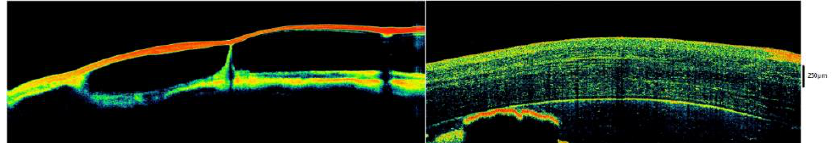
Figure 7. Degeneration of the ocular surface epithelia by portable optical coherence tomography (OCT). Using a portable spectral-domain (SD) OCT in research setting, a progressive degeneration of the ocular surface epithelia and underlying layers can be monitored over time in absence of a physiological tear production. The structural disorganization of the ocular surface epithelia (left), or the loss of corneal epithelium (right), is noninvasively revealed by OCT imaging [59–61]. Reflectivity of the en-face OCT image [low intensity = dark / blue to high intensity = red]. The external surface of the corneal epithelium shows a roughness of ~ 0.5 µm along its contour